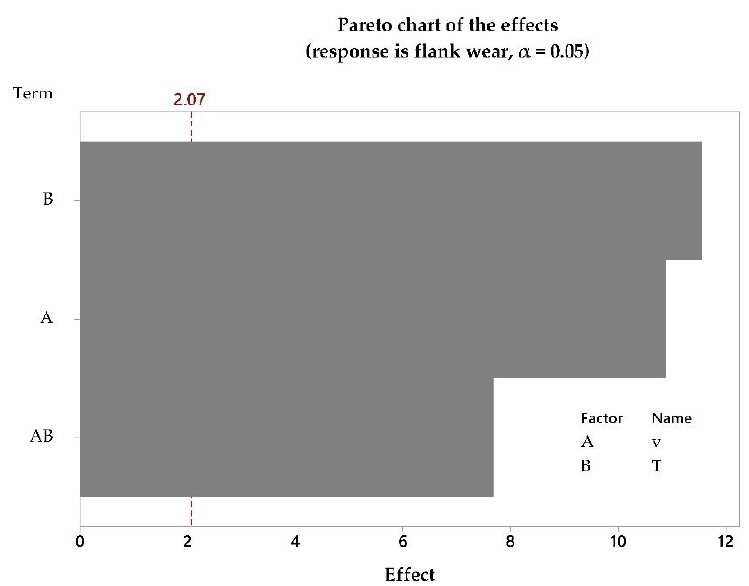
Figure 5. Pareto graphic of variable effects on flank wear, for the GC4225-P25 insert.